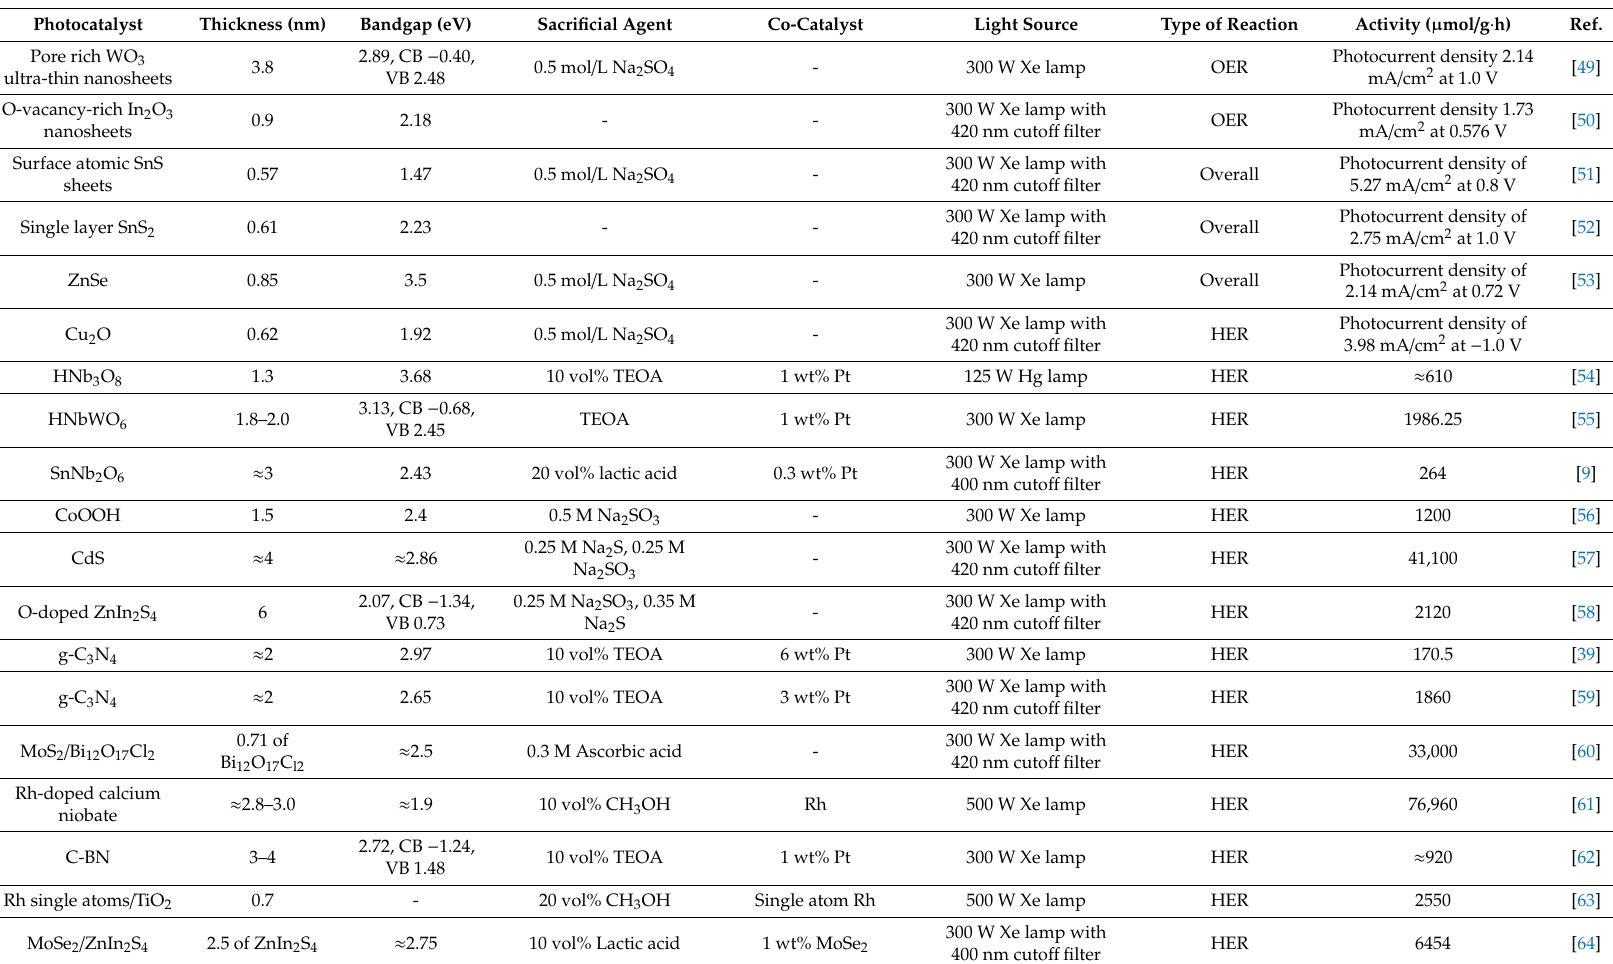
Table 1. A summary of recent studies on ultra-thin 2D photocatalysts. (Adapted with permission from [46], copyright (2017); Wiley and [47], copyright (2019); Nanotechnology, NCBI and [48], copyright (2019), Springer) (Unless otherwise